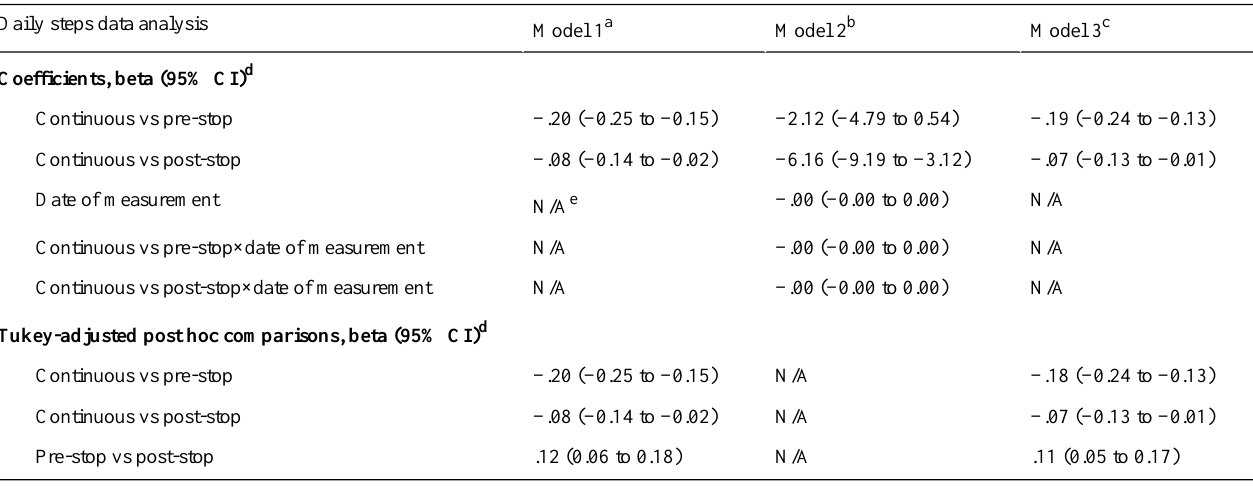
Table 2. Results of the daily steps data analysis of research question